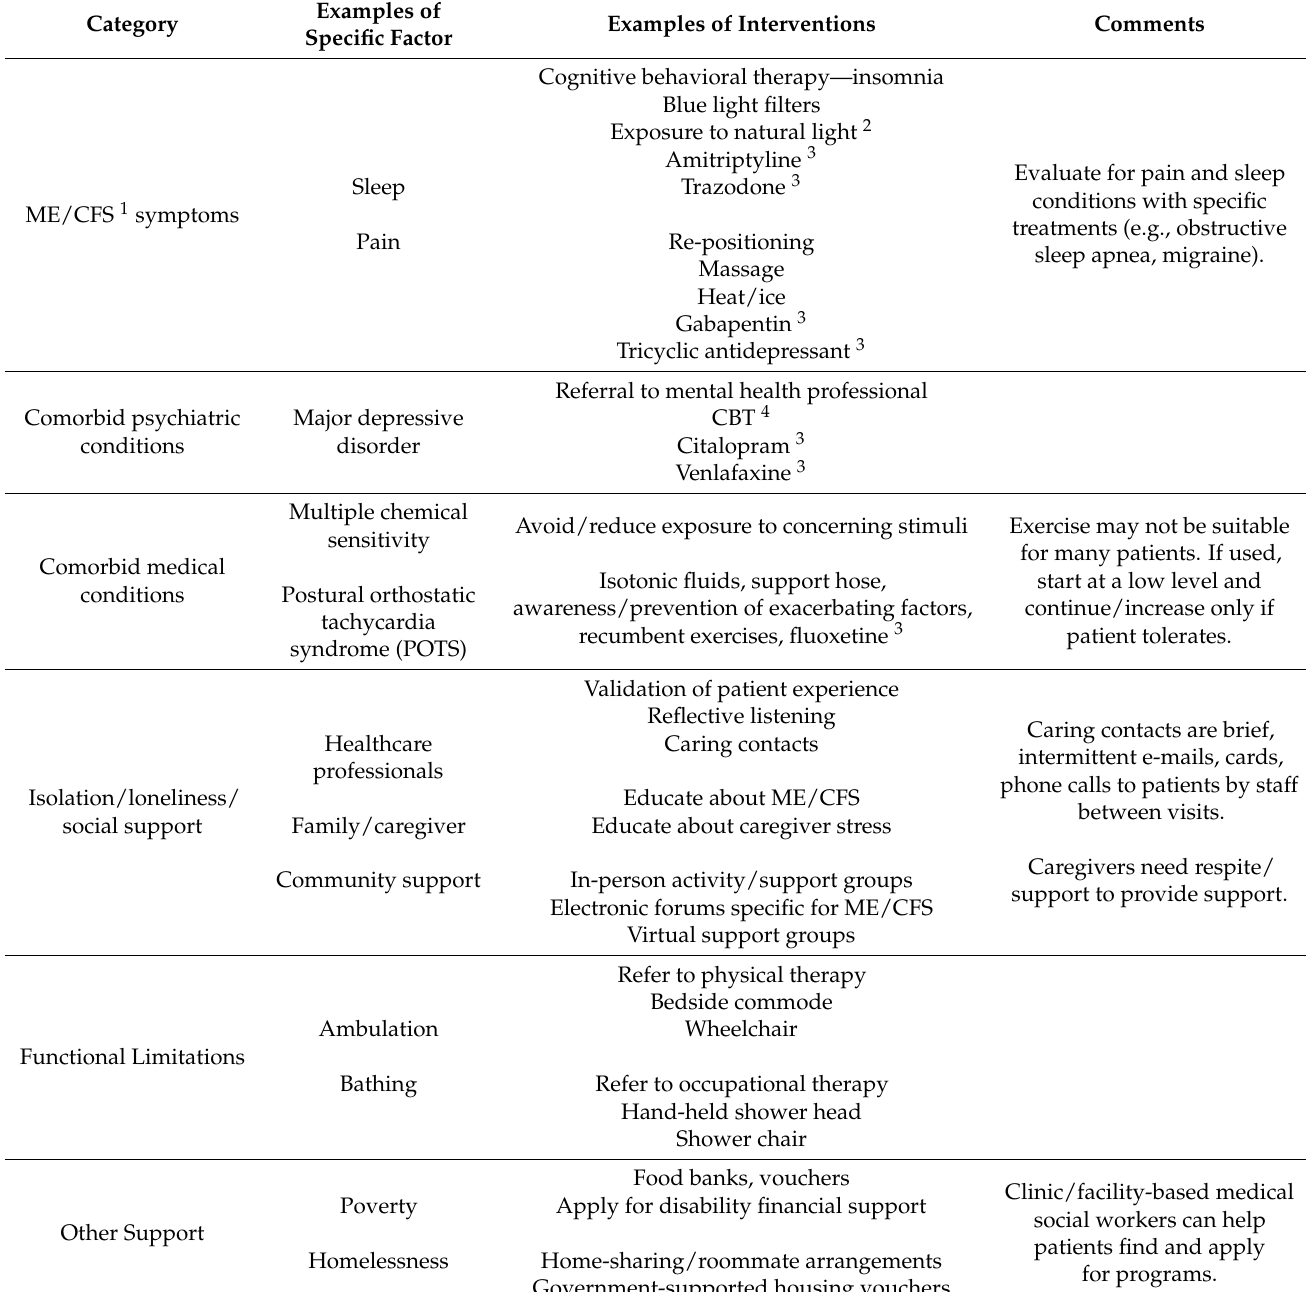
Table 5. Interventions addressing individual-specific risk factors for